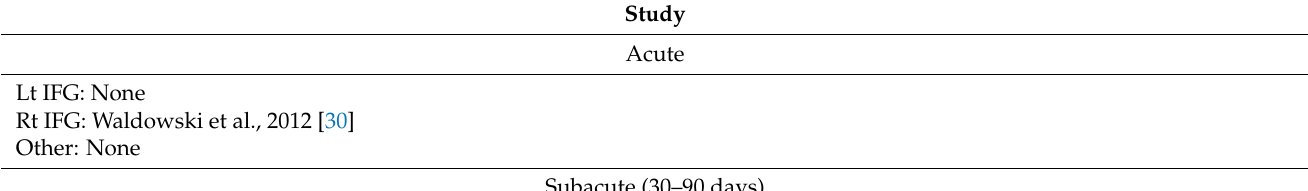
Table 2. Distribution of previous rTMS studies and the timing of intervention from stroke onset. Study